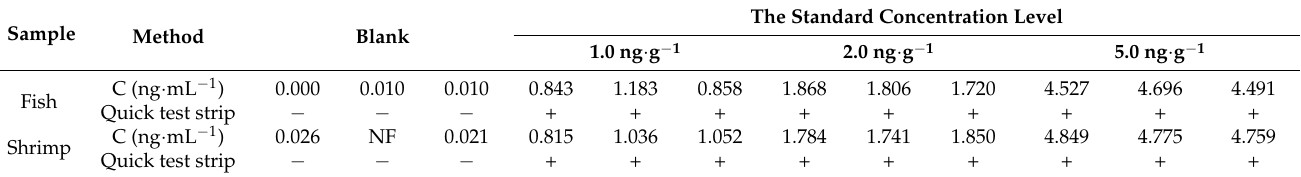
Table 3. Results of LC-MS/MS and quick test strip in spiked